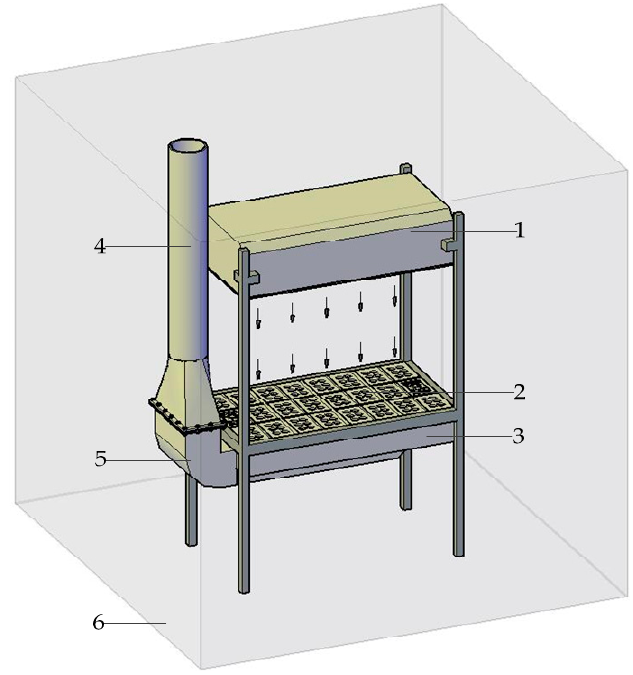
Figure 1. Uniform push–pull ventilation device. 1—Air-supply hood; 2—work surface; 3—exhaust hood; 4—duct; 5—90° rectangular elbow; 6—indoor workplace.